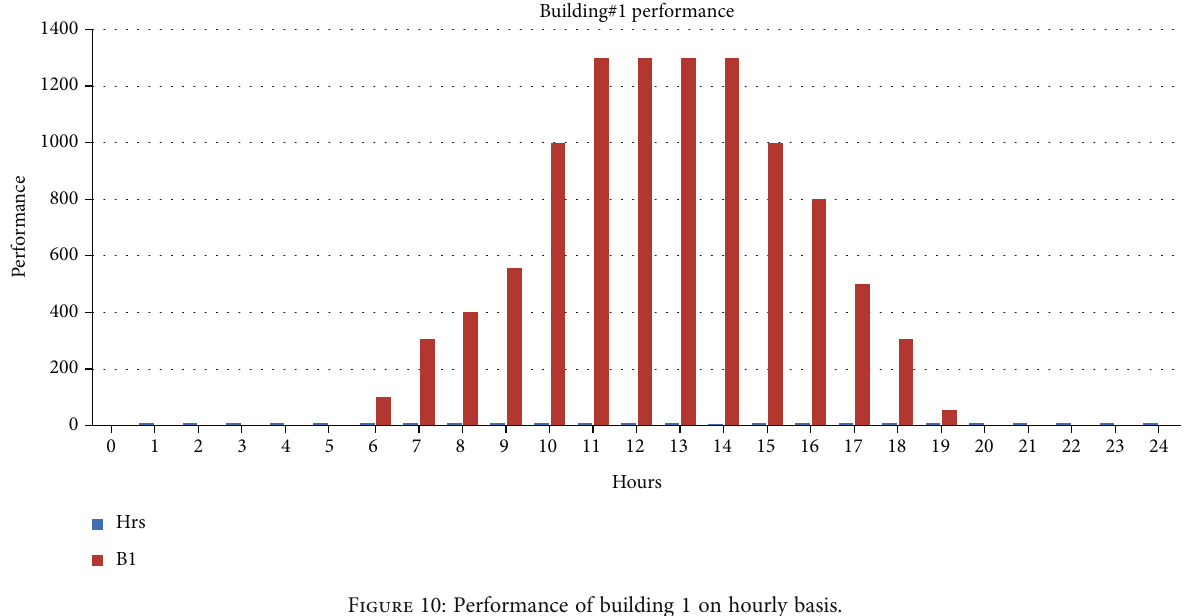
Figure 10: Performance of building 1 on hourly basis.